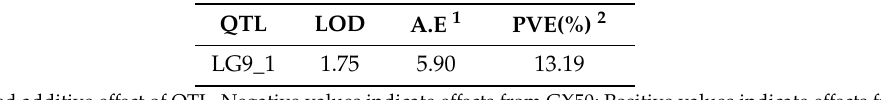
Table 5. E ff ects of the QTL on the regeneration rate detected in F1 populations (GX71).